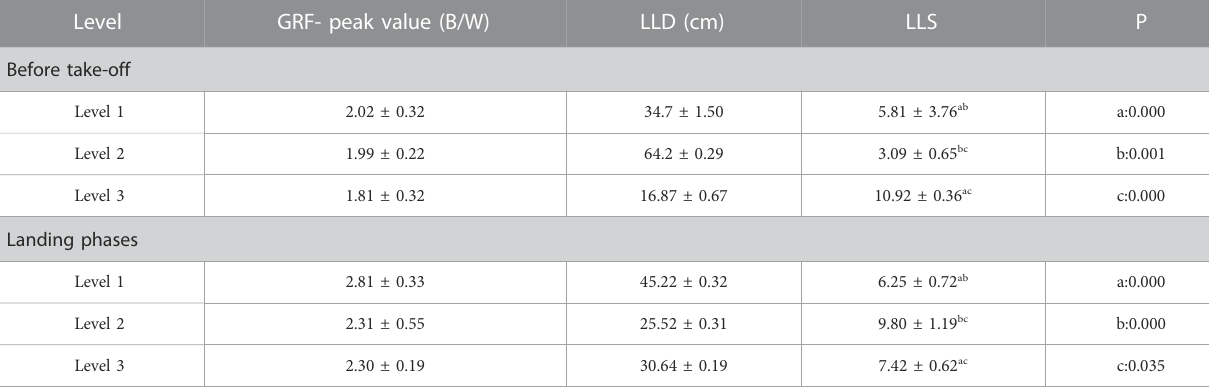
TABLE 6 Lower-limb stiffness of level 1, level 2, and level 3 during FUS.